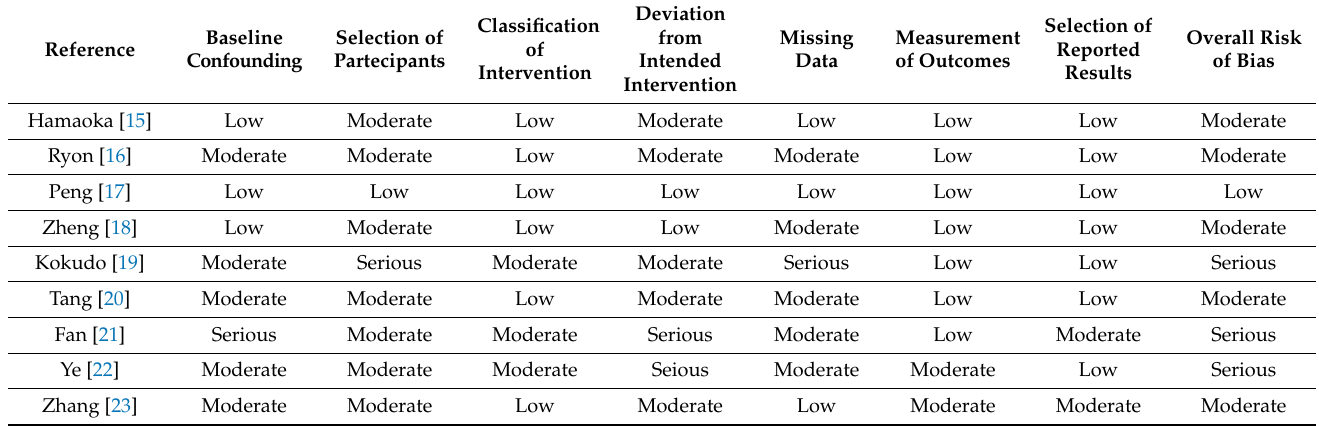
Table 3. Risk of bias